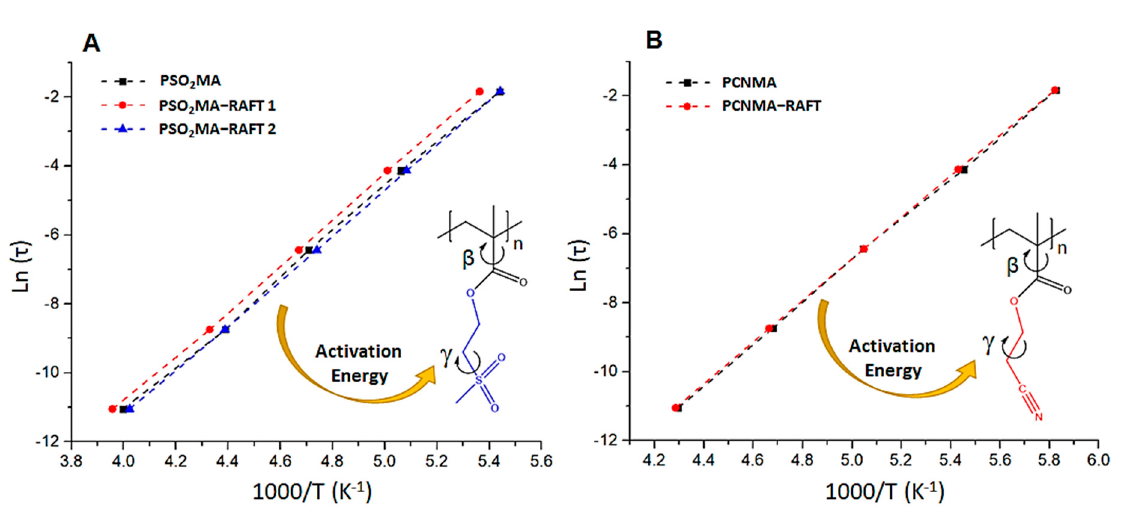
Figure 8. Arrhenius plots for polymethacrylates containing sulfonyl ( A ) and nitrile functional groups ( B ) .